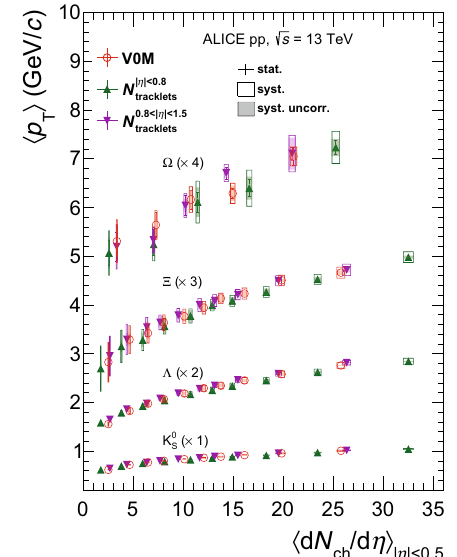
Fig. 5 (cid:3) p T (cid:4) of K 0 , (cid:3) , (cid:4) , and (cid:5) in multiplicity event classes selected S accordingtodifferentestimators(seetextfordetails).Statisticalandsys- tematic uncertainties are shown by error bars and empty boxes, respec- tively.Shadowedboxesrepresentuncertaintiesuncorrelatedacrossmul- tiplicity